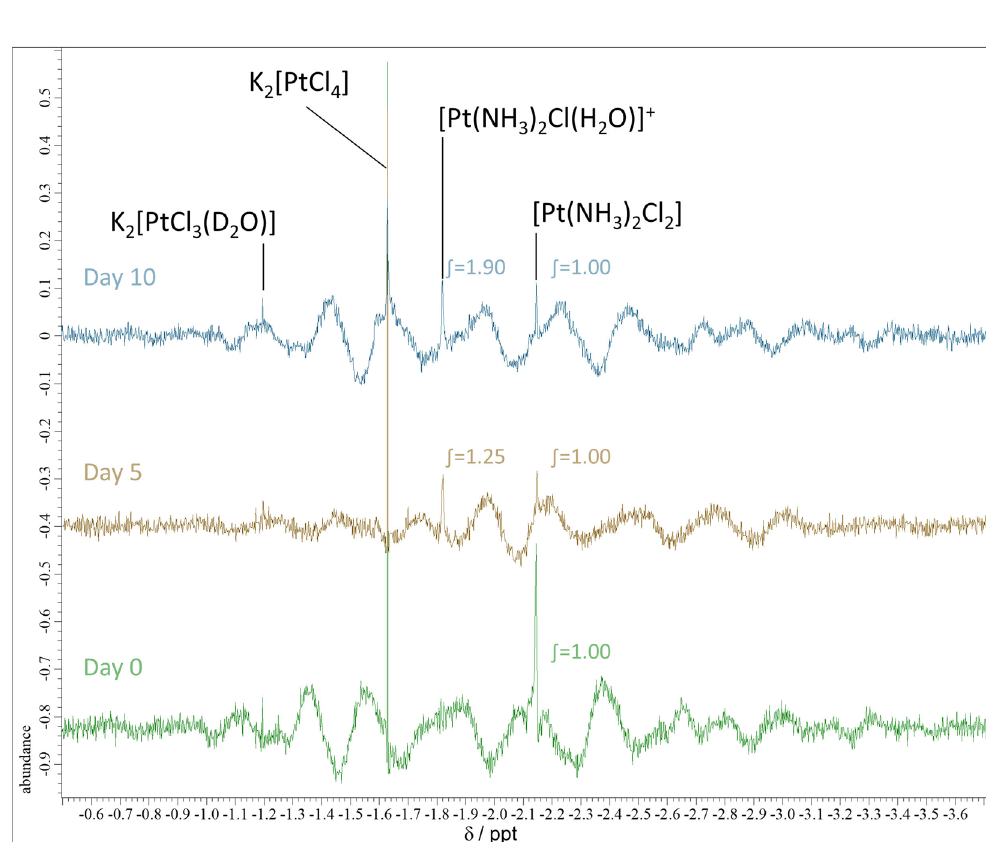
Figure 2. 195 Pt NMR spectra of cisplatin dissolved in 50 wt% TMG aq. Pt(NH 3 ) 2 Cl 2 : − 2145 ppm,